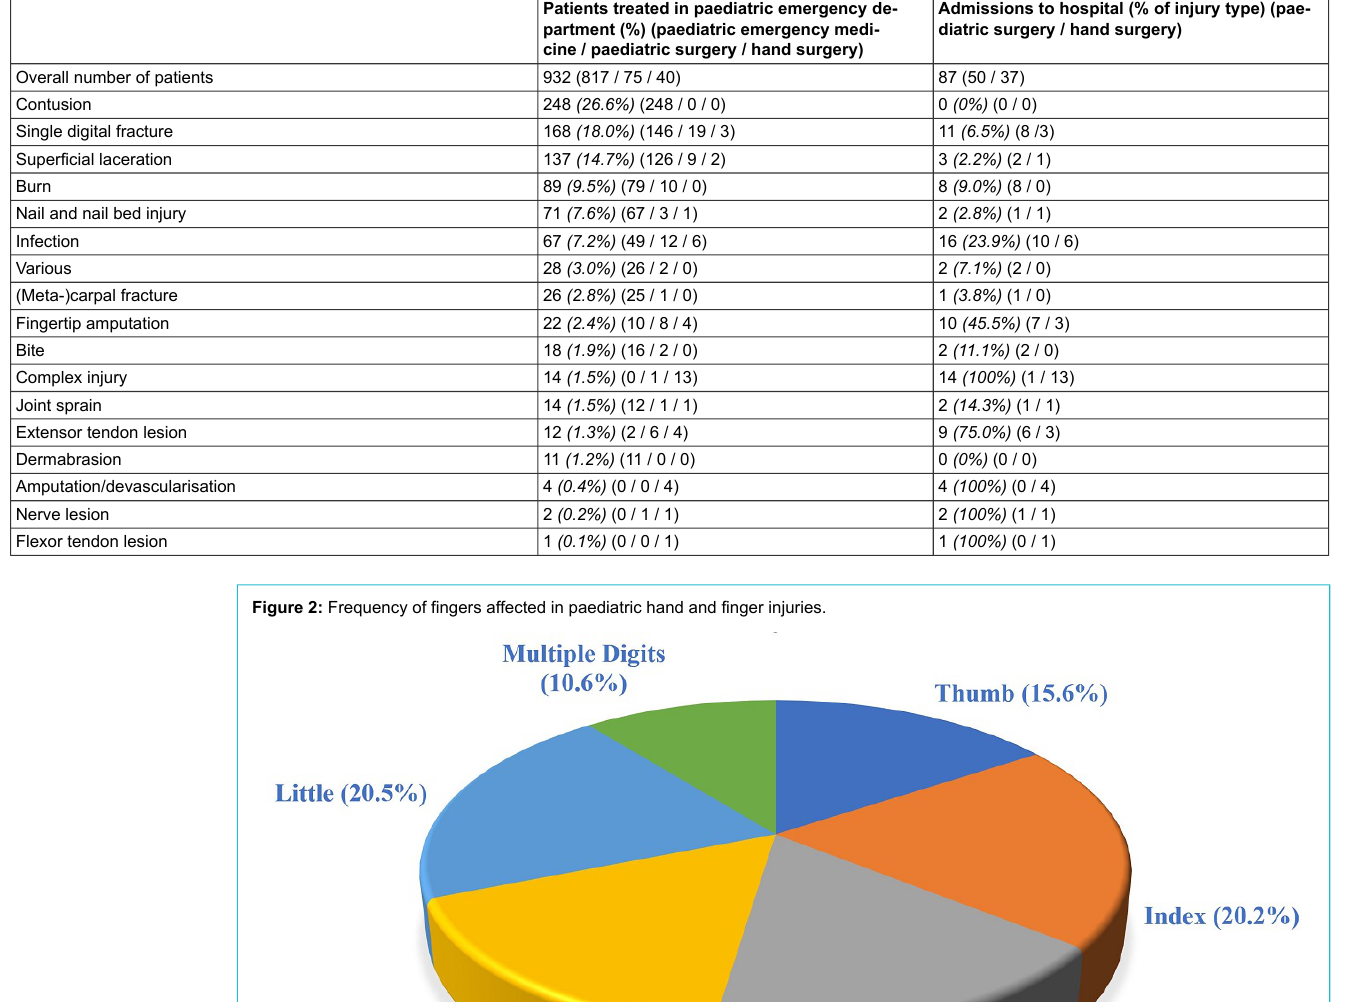
Table 2: Causes for presentation to paediatric emergency department and admission to hospital per injury type.